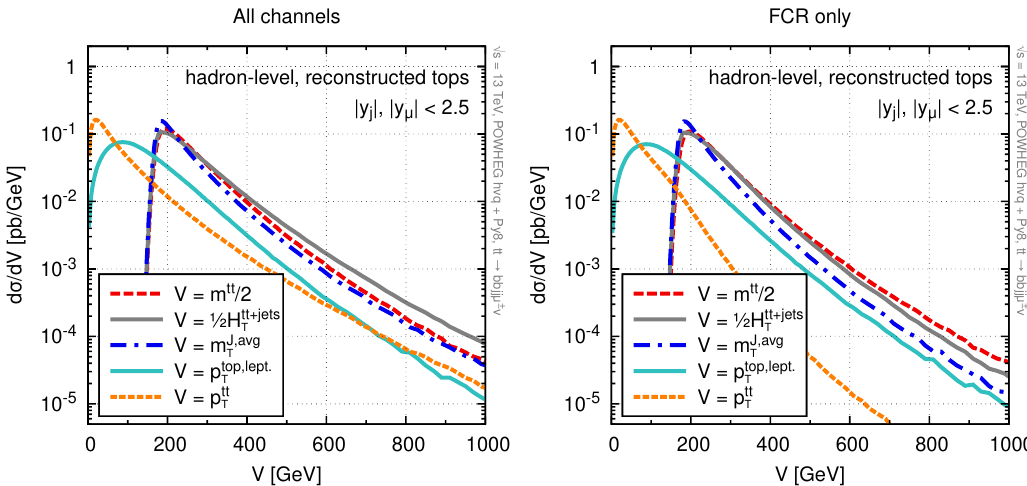
Figure 8 . Hadron level results with reconstructed tops, for differential cross sections as a function of a selection of scales used to characterise the event hardness ( V ), for a subset of such scales. Left-hand plot: results summing over all topologies. Right-hand plot: results for just the FCR topology. This plot is to be compared to figure 4. The results here include a rapidity acceptance cut of | y | < 2 . 5 for jets and muons.